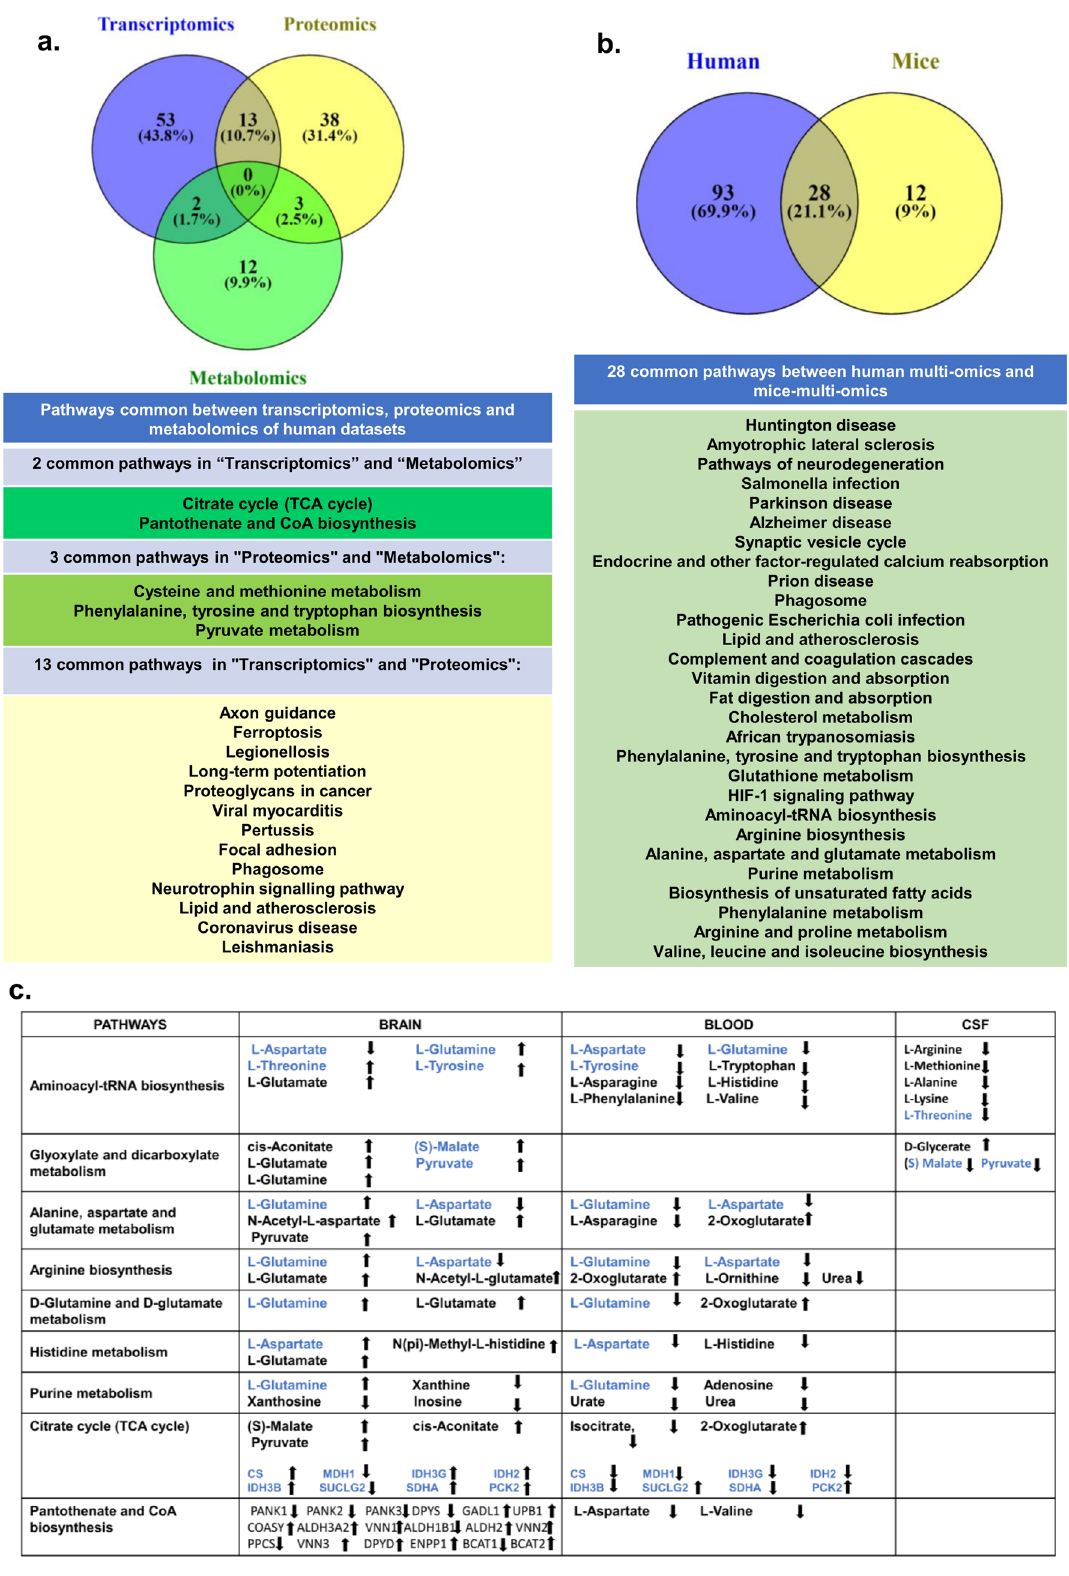
Figure 5. ( a ) Common pathways between transcriptomics proteomics and metabolomics from human datasets. ( b ) Common pathways between mice multi-omics data and human multi-omics data. ( c ) Metabolite expression levels of common metabolic pathways in humans. Metabolite and gene expression levels pathways common between transcriptomics and metabolomics in humans. Figure generated using Venny (bioinfogp.cnb.csic.es/ tools/venny/), Microsoft powerpoint 2019 MSO (Version 2212 Build 16.0.15928.20196)